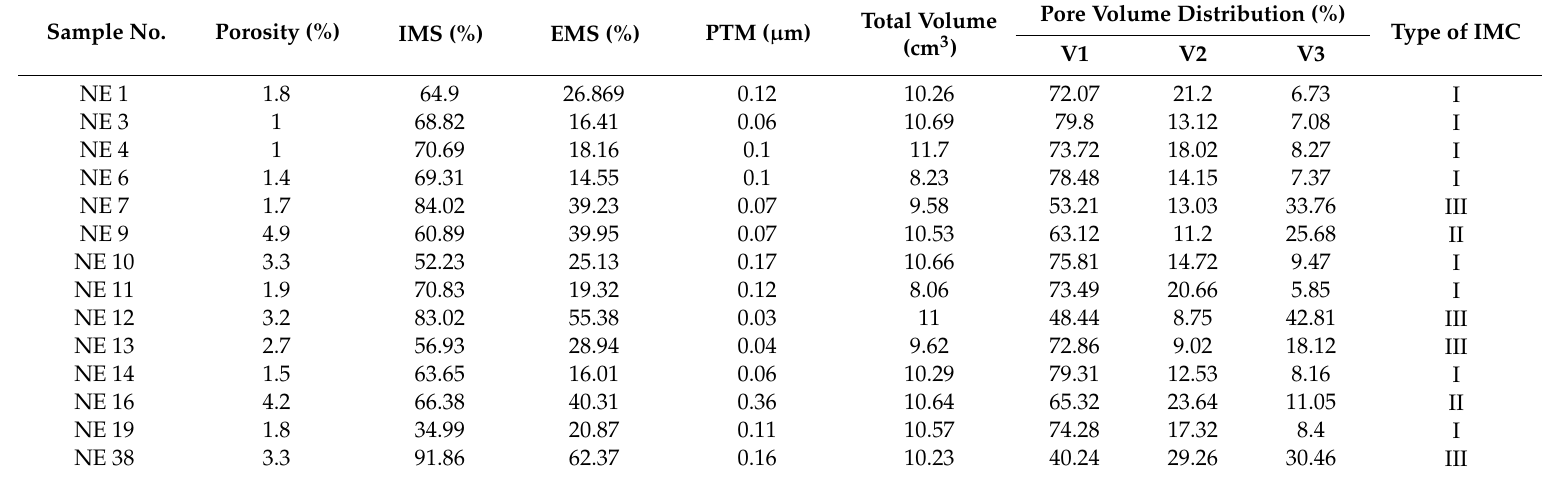
Table 2. Pore analysis and mercury porosimetry results of the selected coal samples. Sample